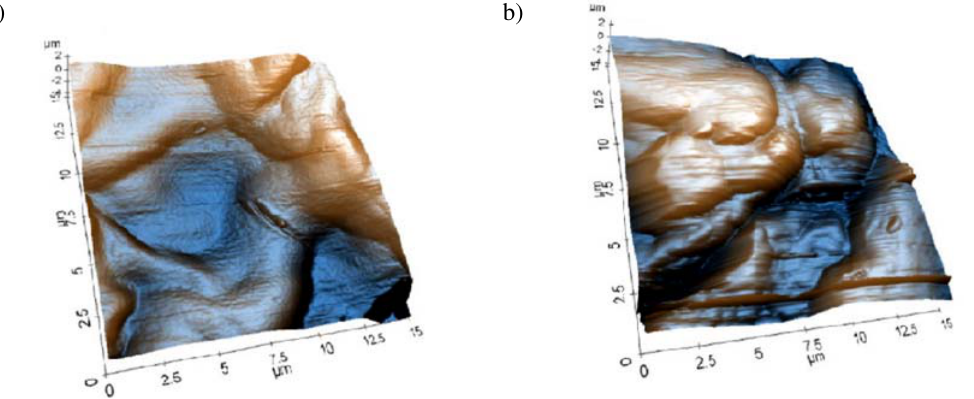
film before (a) and after (b) dyes removal process 2